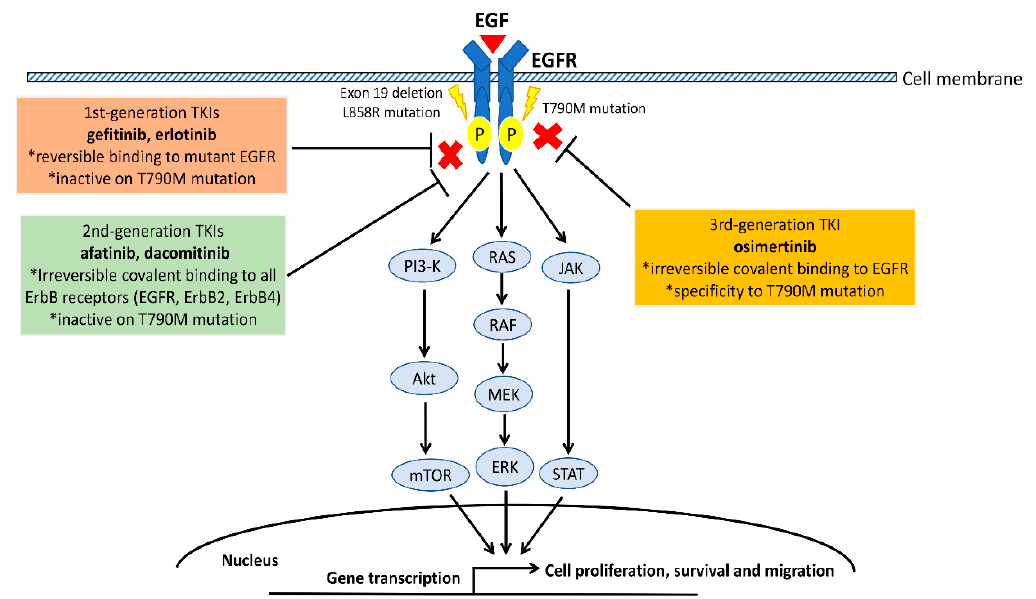
Figure 1. The Epidermal growth factor receptor (EGFR) pathway in non-small cell lung cancer (NSCLC). EGFR kinase domain mutations including exon 19 deletion, L858R and T790M increase kinase activity of EGFR, leading to the hyperactivation of downstream signaling pathways including MAPK, PI3K / Akt / mTOR, and IL-6 / JAK / STAT3 which promote tumorigenesis of NSCLC cells. The three generations of EGFR-TKIs di ff er with respect to how they bind to di ff erent EGFR mutations and which EGFR mutations are active or inactive.